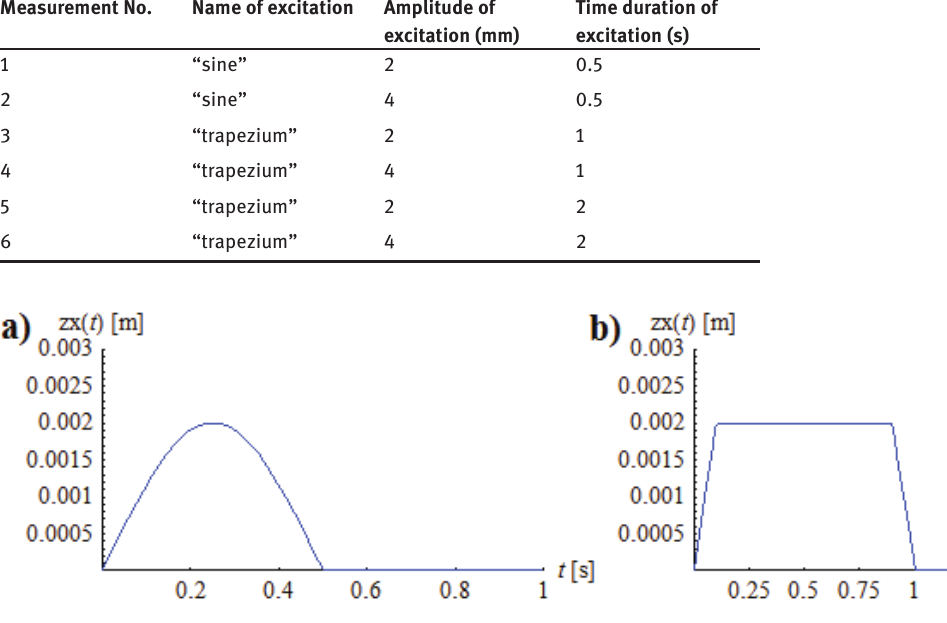
Table 1: Data on kinematic excitations. Measurement No.